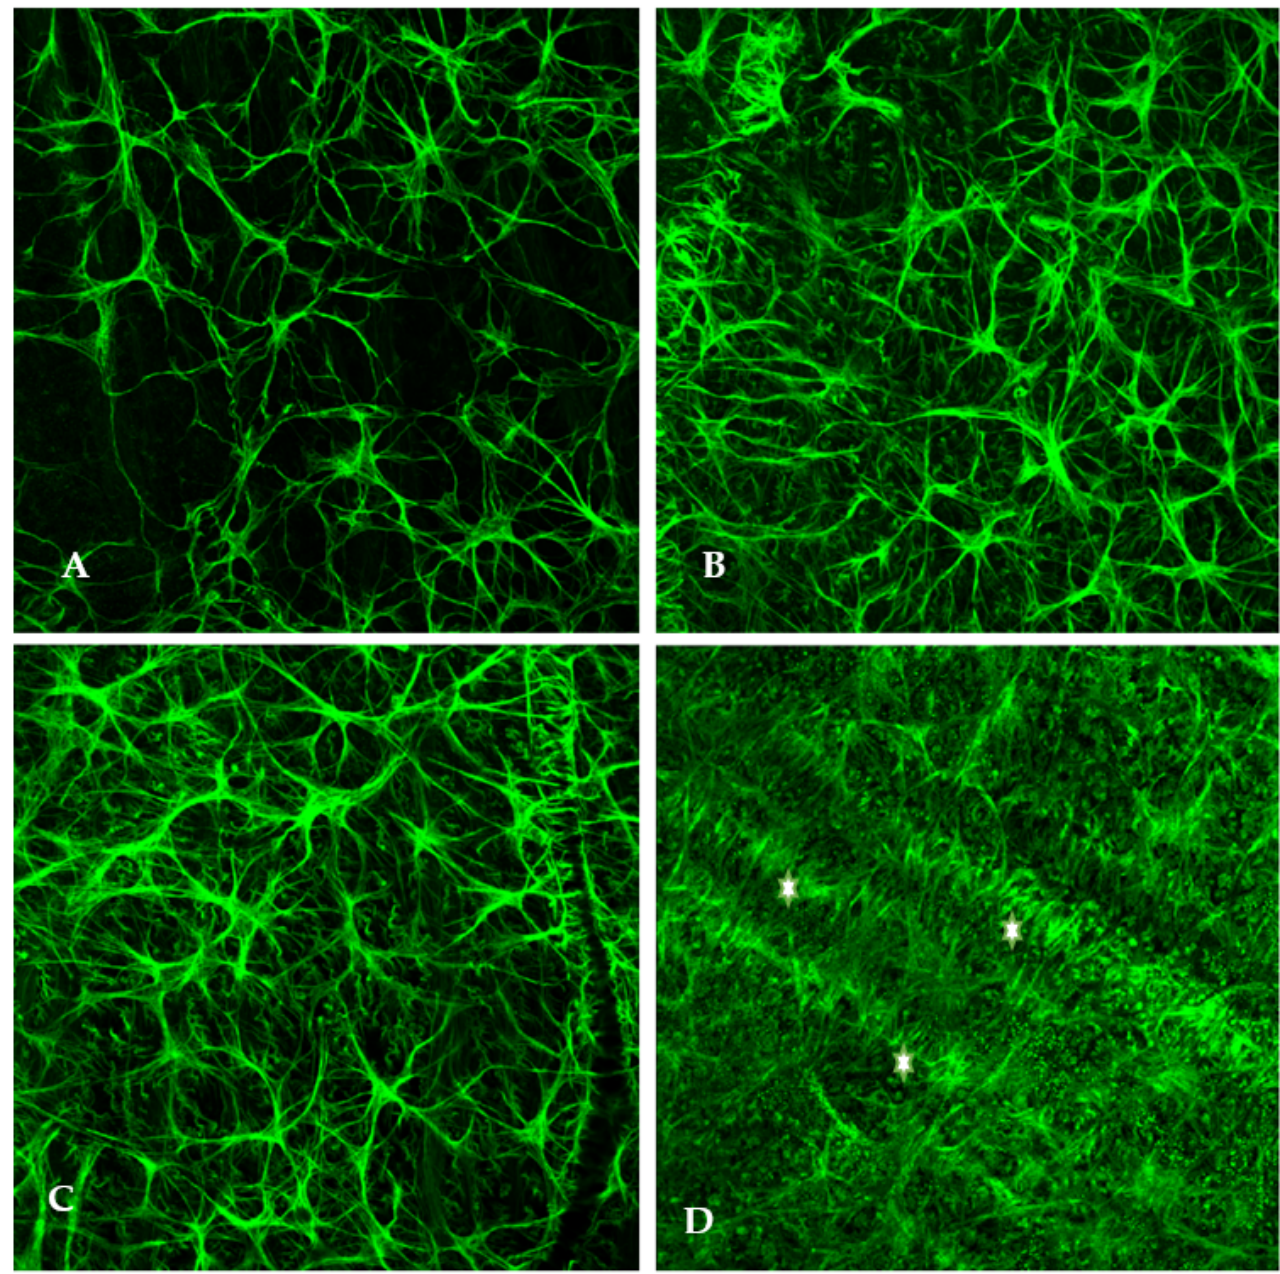
Figure 1. Flat mounted Rat retinas stained with antibodies against glia fibrillary acidic protein (GFAP) at mid retinal positions showing labelled astrocytes. ( A ) Normal control retina. ( B ) 4 days after elevation of IOP. ( C ) 7 days after IOP elevation. ( A – C ) were photographed at 40X objective. ( D ) 7 days after IOP elevation same as in ( C ) except photographed at 10X objective. High levels of GFAP expression and astrocytic hypertrophy appeared within 4 days after IOP elevation. In ( D ), the stars point to spaces where bundles of optic axons navigate. Profusion of astrocytes are aligned to the retinal ganglion cell axons.